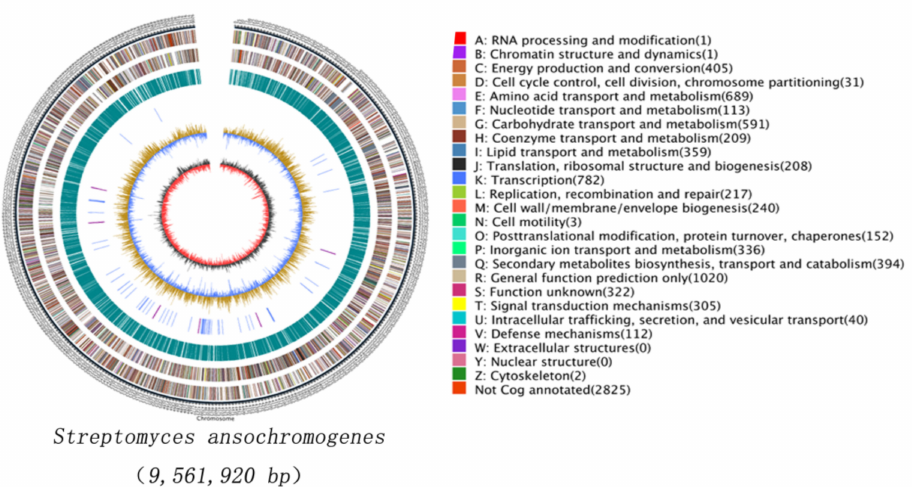
Figure 1. Circular representation of the Streptomyces ansochromogenes chromosome. The circle 1 (outer circle) is a marker of genome total size with a scale of 5 kb each; circles 2 and 3 (from the outside in) are genes on the forward and reverse strand respectively, which are color-coded by function; circle 4 indicates the distributed position of repeat sequence; circle 5 represents tRNAs and rRNAs; circle 6 shows GC content (the light yellow part indicates that the GC content in this region is higher than the average GC content in the genome, the blue part indicates that the GC content in this region is lower than the average GC content in the genome), circle 7 (inner circle) is GC-skew (Black represents the area where G content is greater than C, and red represents the area where C content is greater than G).